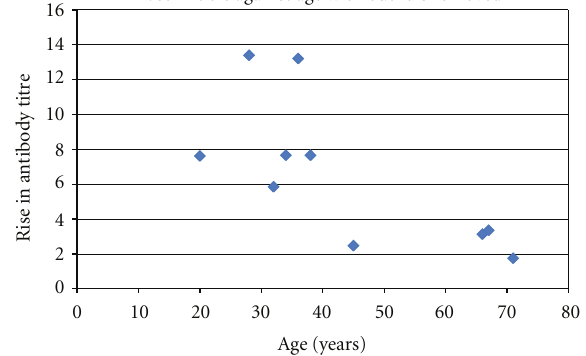
Figure 2: Scatter plot of rise in tire after boosting with outliers removed against age.